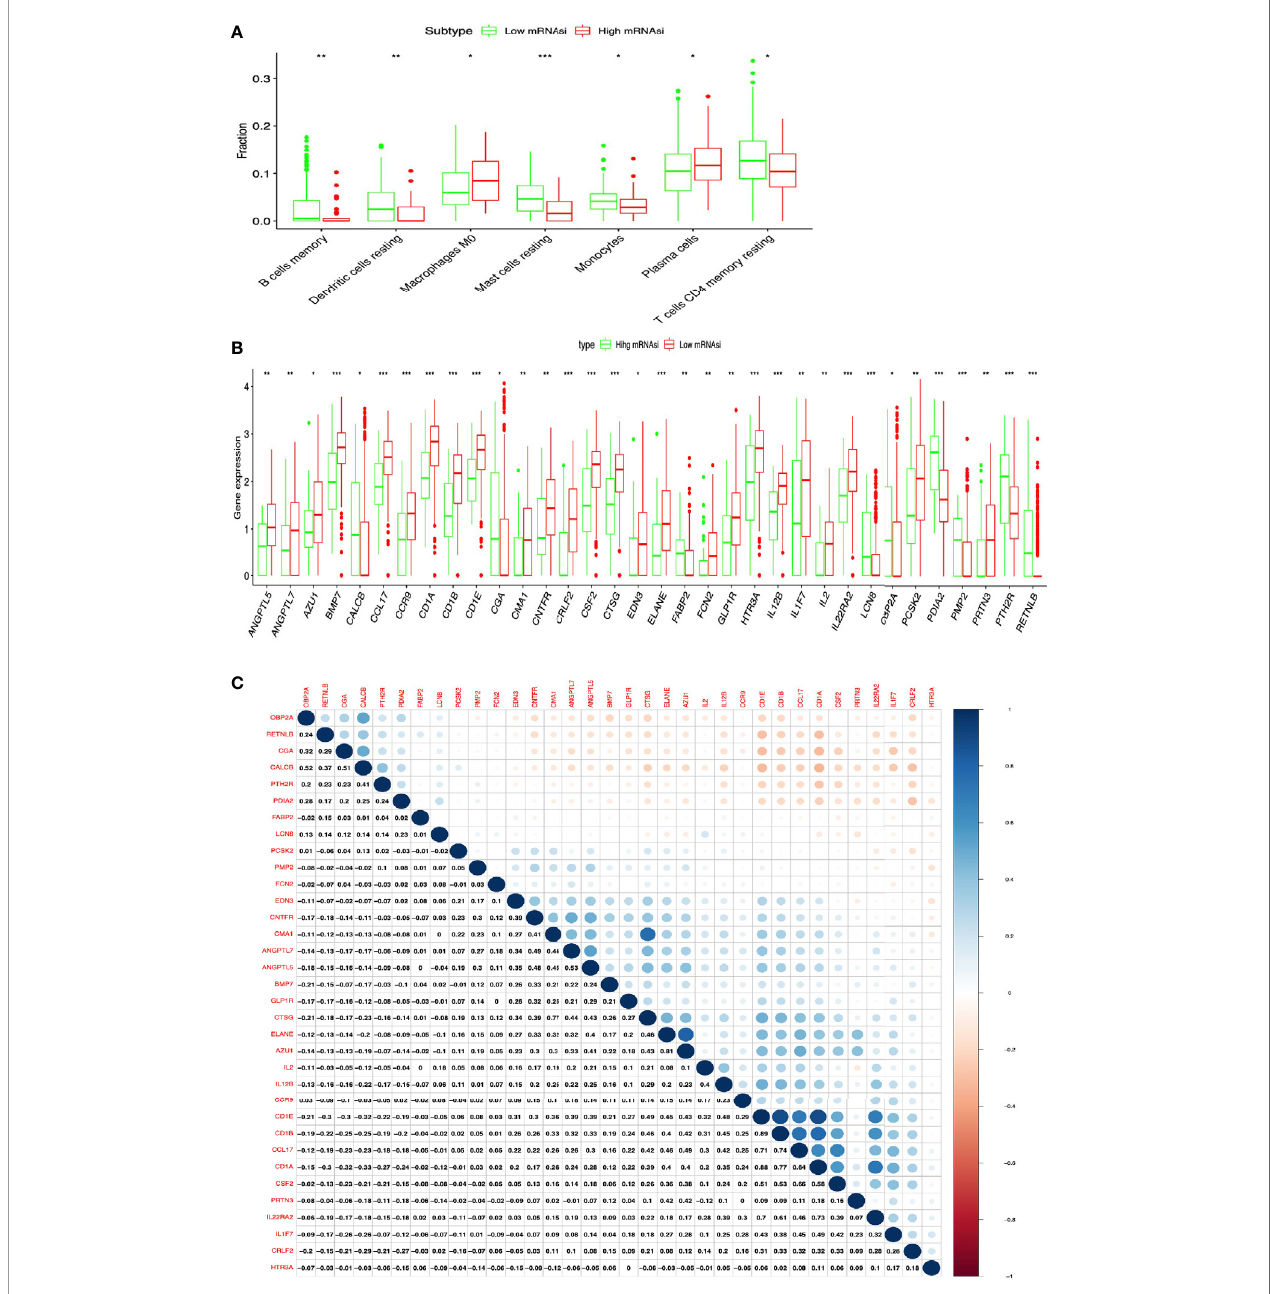
FIGURE 3 | Identi fi cation of DEIRGs between higher- and lower-mRNAsi groups in LUAD. (A) The distribution of immune cells between higher- and lower-mRNAsi groups. (B) DEIRGs between higher- and lower-mRNAsi groups. (C) The correlation between DEIRGs. *p < 0.05, **p < 0.01, ***p <